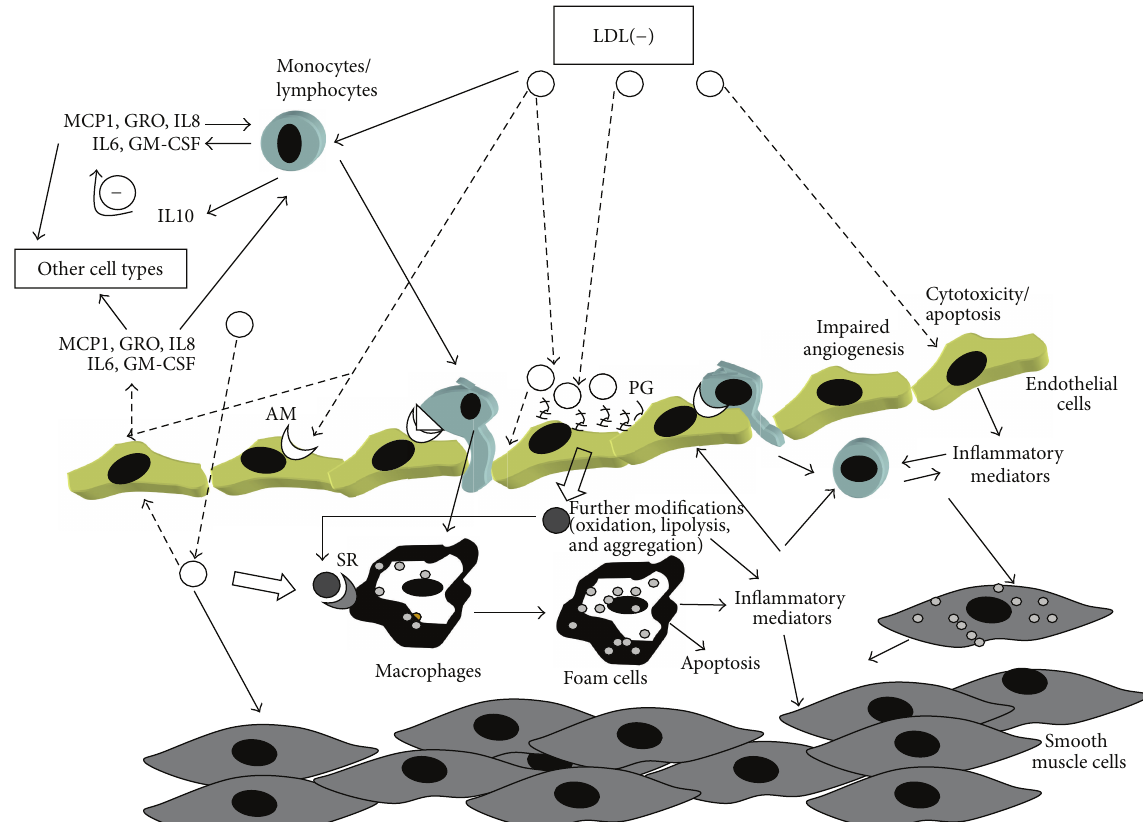
Figure 2: Biological actions of LDL( − ) on circulating mononuclear cells (monocytes/lymphocytes) and arterial wall cells (endothelial cells, macrophages and smooth muscle cells) in relation to atherogenesis. LDL( − ) can activate circulating leukocytes, mainly monocytes, and lymphocytes. LDL( − ) also induces chemokine and adhesion molecules in endothelial cells, promoting the recruitment of more circulating leukocytes to endothelium. Cytokines released by endothelial cells can also act on other cell types of the arterial wall. LDL( − ) retained in the subendothelial space by its increased binding to PG can also stimulate arterial wall cells. In this environment, LDL( − ) could be further modified, leading to additional inflammatory actions on cells. It could also be uptaken by SR, promoting the formation of foam cells. LDL( − ): electronegative LDL, MCP1: monocyte chemoattracting-protein 1, GRO: growth-related oncogen, IL6, IL8, and IL10: interleukin 6, 8, and 10, GM-CSF: granulocyte monocyte-colony stimulating factor, SR: scavenger receptor, AM: adhesion molecule, PG: